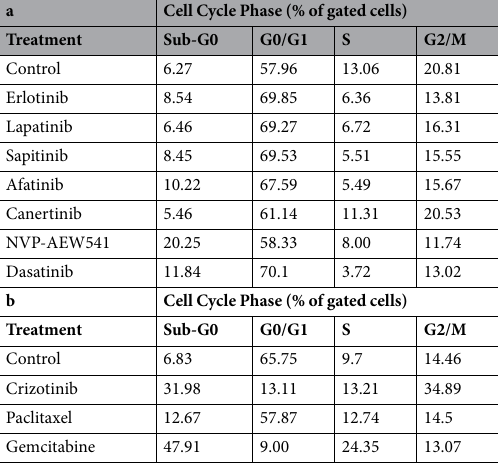
Table 4. Effect on cell cycle distribution of SKBr3 cells following treatment with various agents. (a) HER-family inhibitors, NVP-AEW-541 and Dasatinib; (b) Crizotinib, paclitaxel and